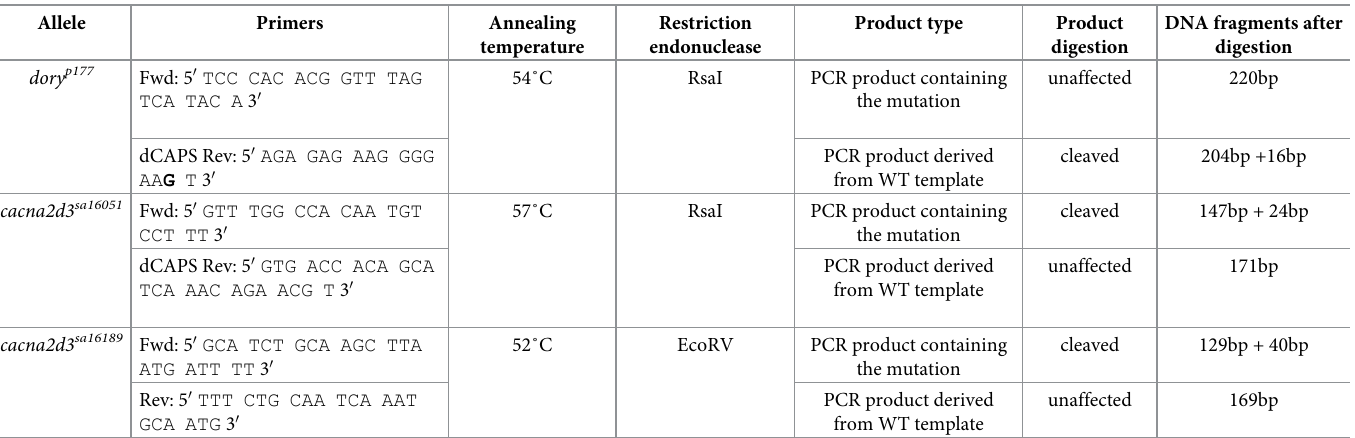
Table 1. Genotyping primers and genotyping conditions.